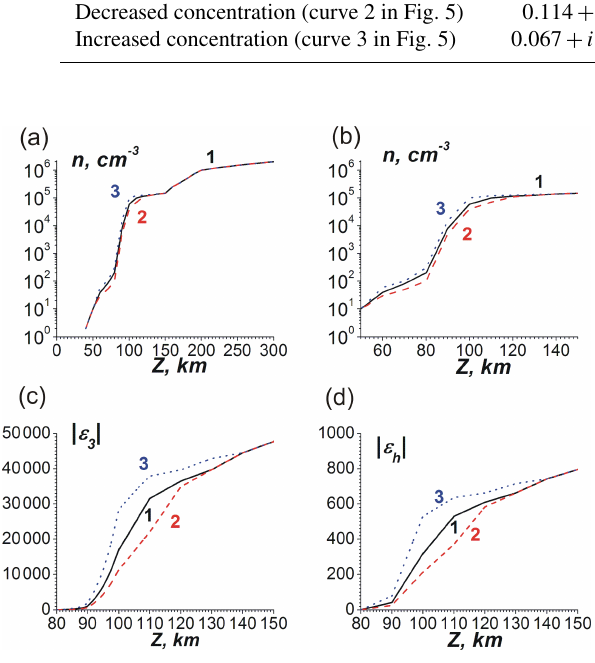
Table 1. The values of tensor impedance components corresponding to the data shown in Fig. 5. Component of the tensor impedance Z 011 Undisturbed concentration (curve 1 in Fig. 5) Decreased concentration (curve 2 in Fig. 5)